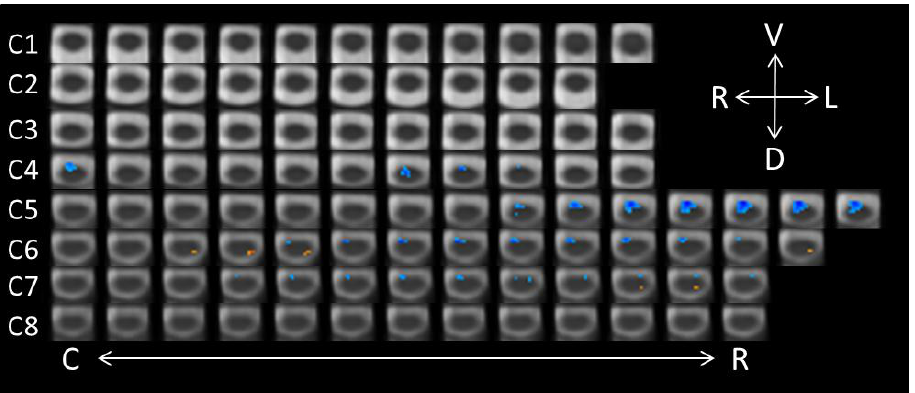
Figure 3. Axial spinal cord slices presenting the distribution of activity produced during the Anger-Conscious/Fear-Conscious contrast (−1, 1). The images are oriented in radiological convention with dorsal towards the bottom of each frame, left side of the cord on the right of each frame, and are displayed caudal-to-rostral from left to right of each row (α = 0.00556). The abbreviations related to the axial directions (top-right of the figure) are defined as follows: R = right; L = left; V = ventral; D = dorsal. The abbreviations C and R (bottom of the figure) refer to caudal and rostral, respectively.